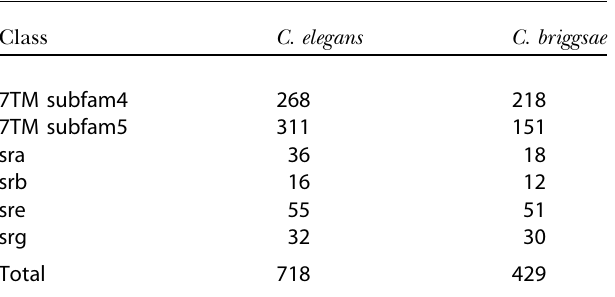
Table 4. Differential Sizes of Chemosensory Receptor Subfami- lies in C. elegans and C.